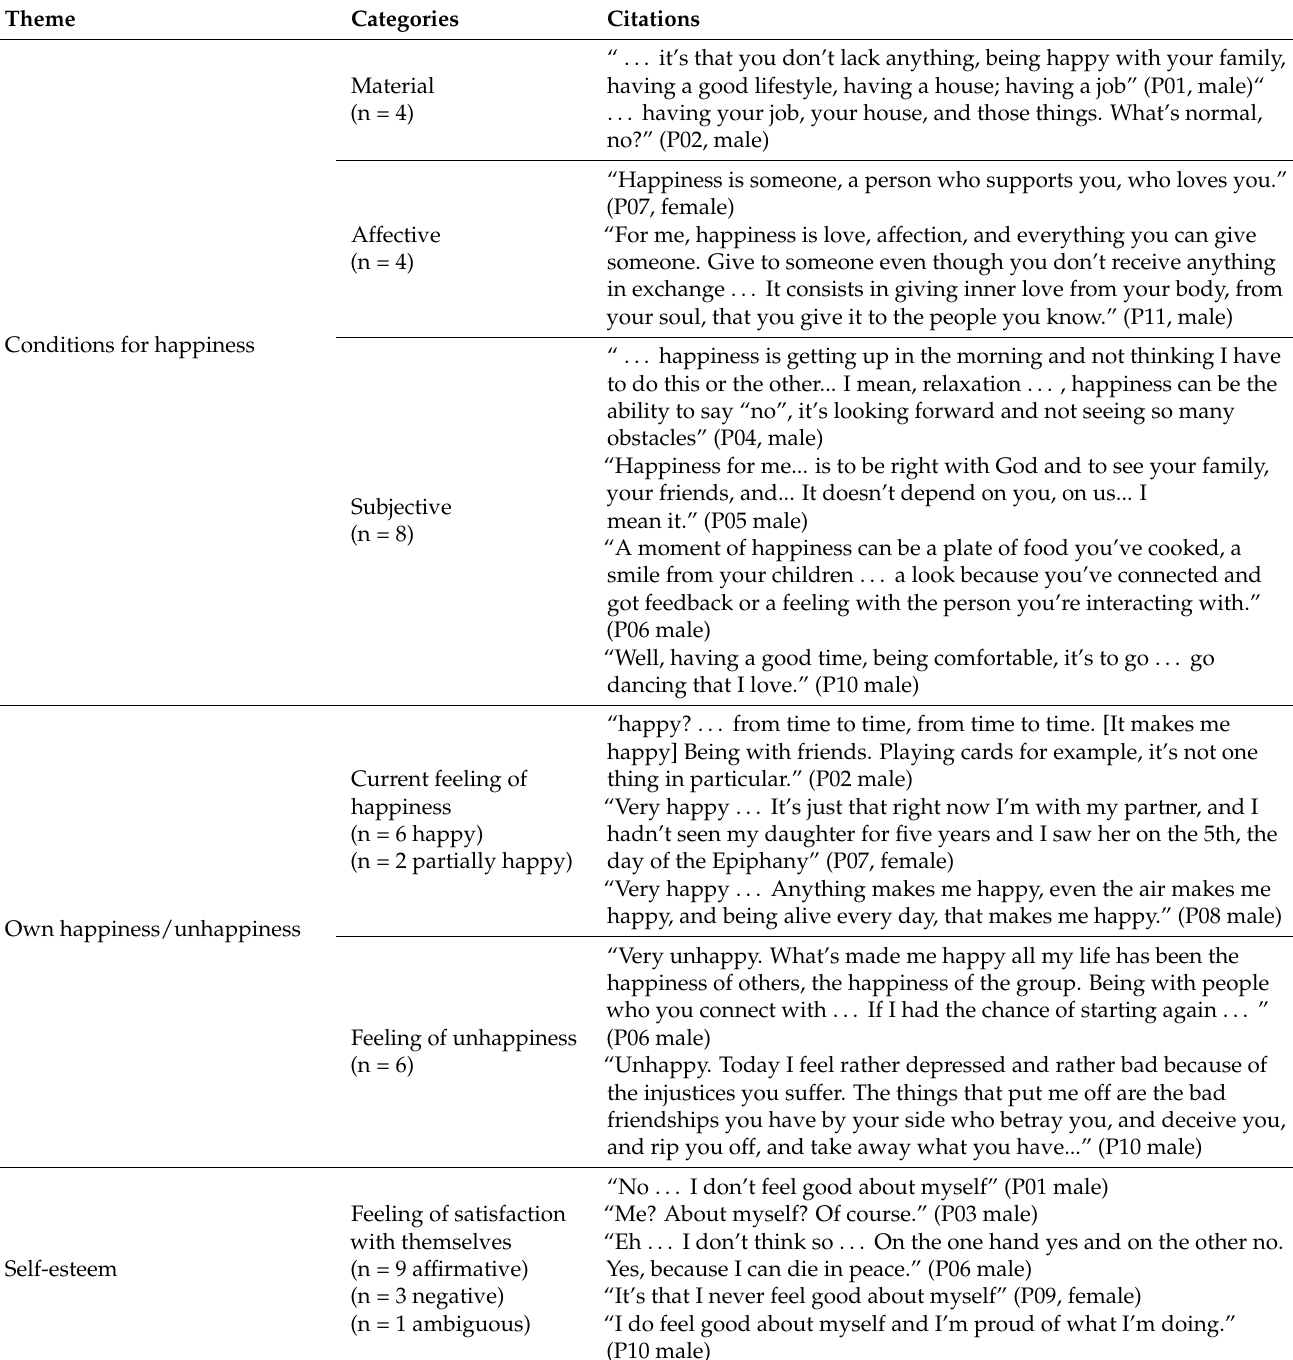
Table 5. Themes, categories, and textual citations of the